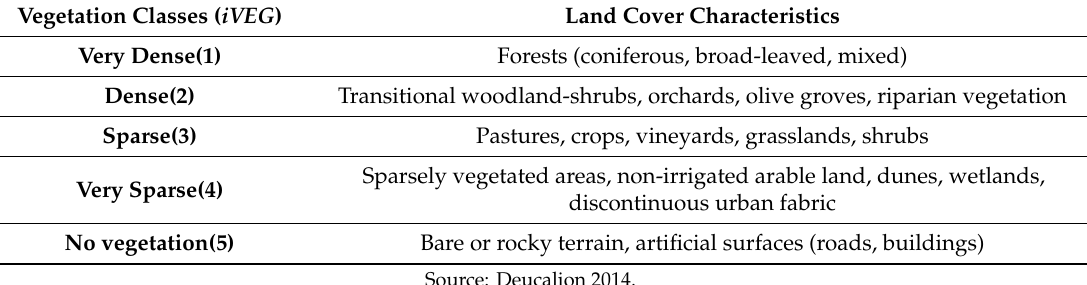
Table 4. Vegetation classes (iVEG) based on land cover characteristics.